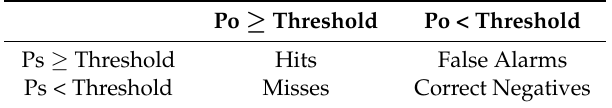
The contingency table presents the agreement between observed records (P o ) and satellite-based retrievals (P s ) of rainfall for different rainfall intensity ranges.